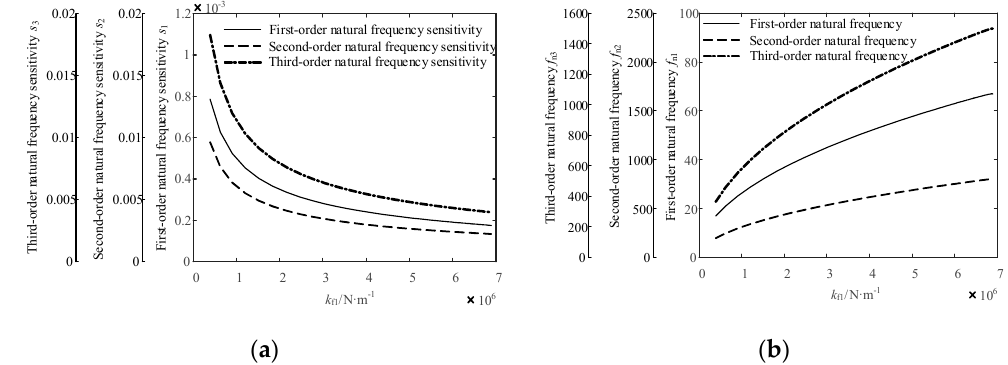
Figure 9. The variation law of the first three natural frequencies and their sensitivities of the jet system under a different pressure of the fluid with the stiffness of fluid unit 1. ( a ) Variation law of natural frequency sensitivity. ( b ) Variation law of natural frequency.